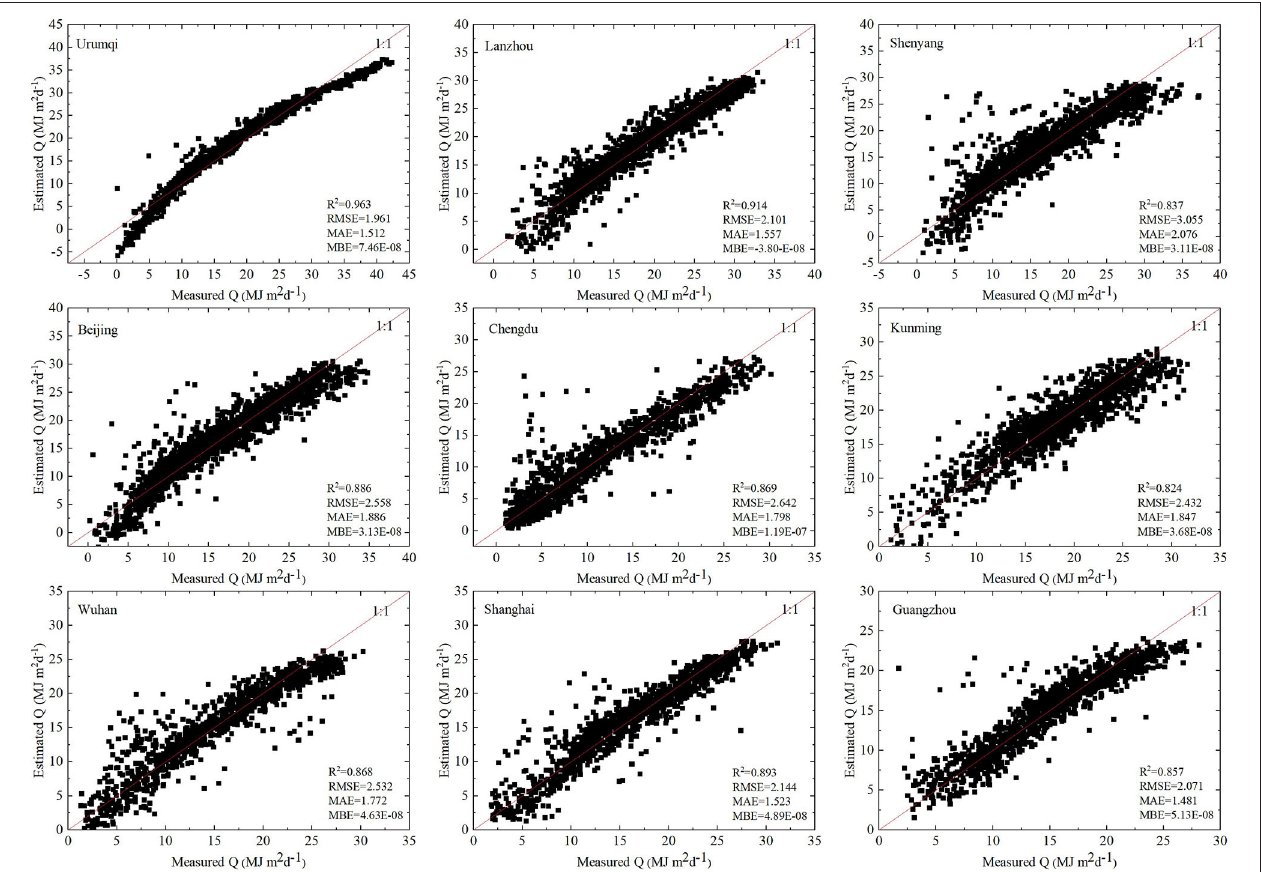
FIGURE 5 | Scatter plot of predicted values and measured values of model-C.